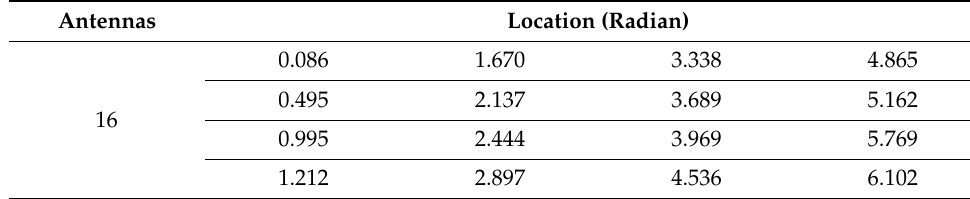
Table 2. 16 cells two-dimensional circle-asymmetric array. Antennas Location (Radian)